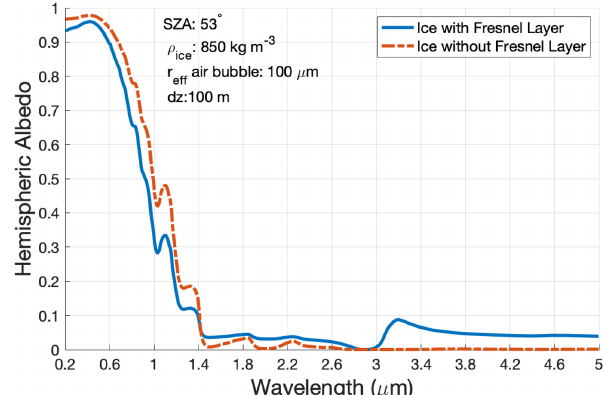
Figure 5. Ice spectral albedo with and without the refractive bound- ary between air and ice.